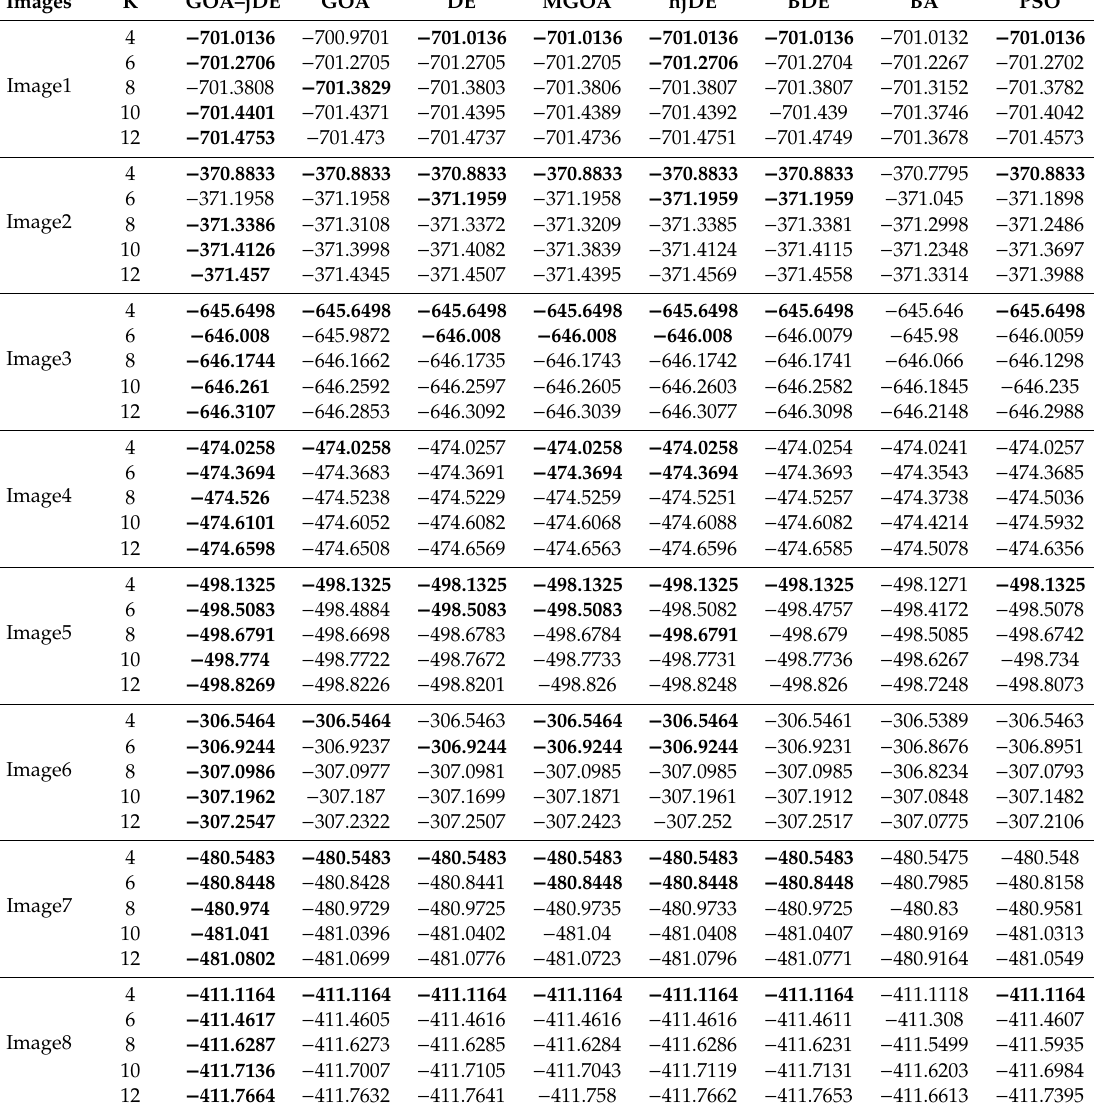
Table 5. The average fitness values using the MCE method compared with other algorithms.